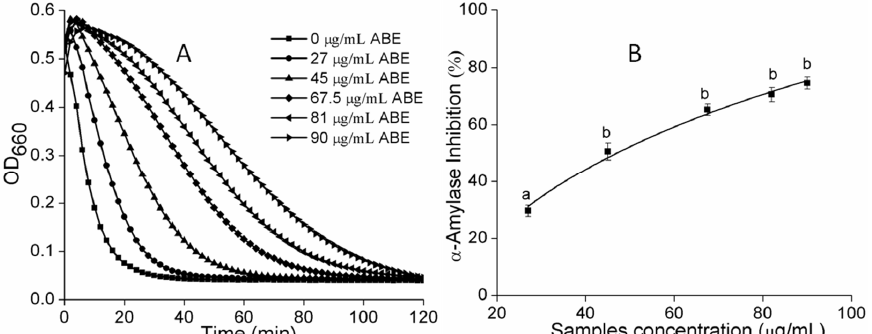
Figure 3. ( A ) The kinetic curves of starch hydrolysis by α -amylase in the presence of different concentrations of ABE; ( B ) Dose–response curve of the α -amylase inhibitory activity of PAs from ABE. Values labeled with the same letter (a–b) are not significantly different from each other ( p < 0.05). symbols represent mean ± SD. The symbols represent mean ± SD. symbols represent mean ± SD.